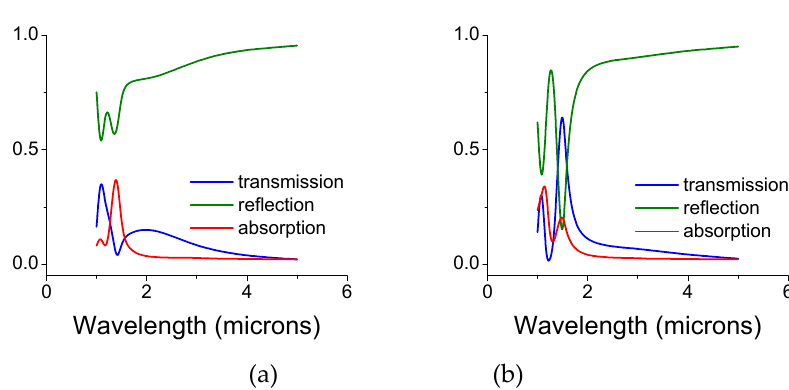
Figure 5. Intensity coefficients for transmission, reflection, and absorption for a diagonally shifted bi-layer screen whose air gap is filled with silica colloids in air. The opening and disk diameters are the reverse of Figure 3: 0.7 and 0.5 microns, respectively. ( a ) The gap is 0.25 microns. ( b ) The gap is 0.5 microns. The thickness of each copper mono-screen is 0.1 microns and the diameter of the colloids equals the gap size.